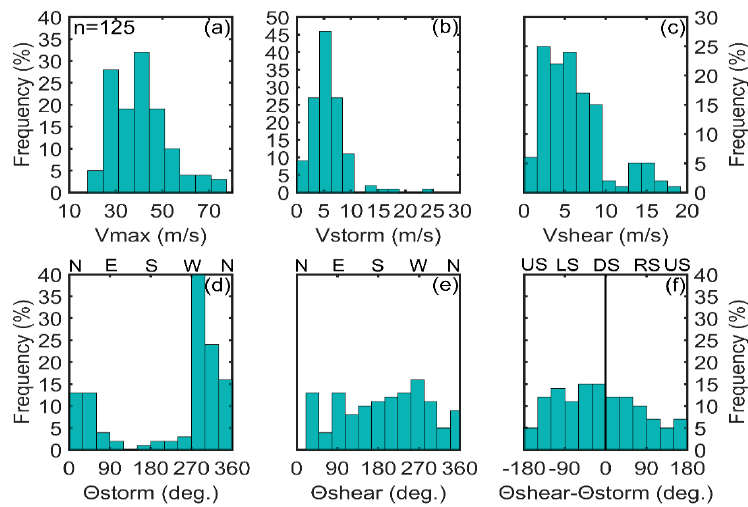
Figure 2. Histograms of parameters used for: ( a ) TC intensity ( V max ); ( b ) TC translation speed ( V storm ); ( c ) environmental vertical wind shear magnitude ( V shear ); ( d ) TC motion direction ( θ storm ); ( e ) environmental vertical wind shear direction ( θ shear ); and ( f ) angle di ff erence between the shear direction and the TC motion direction ( θ shear − θ storm ). Note that 0 ◦ in ( d ) and ( e ) represents North; 0 ◦ in ( f ) indicates that the wind shear and storm motion directions are equal. RS indicates that the wind shear is located on the right side of the TC motion and LS indicates that the wind shear is located on the left side of the TC motion.